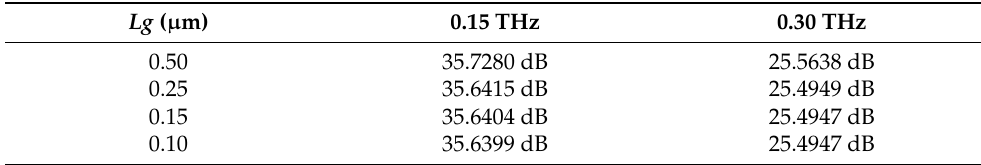
Table 4. Maximum value of the normalized electric field component along y axis in dB for frequencies 0.15 and 0.30 THz considering the effect of the bonding wires.